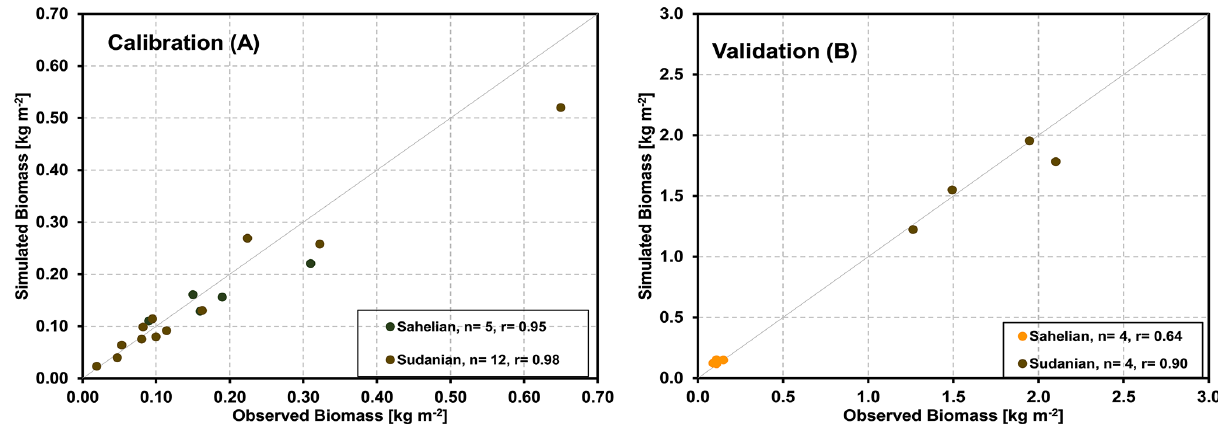
Figure 8. Correlations between the observed and modeled biomass production at different tree-dominated grassland/woodland sites in Sahe- lian and Sudanian ecological zone through calibration and validation